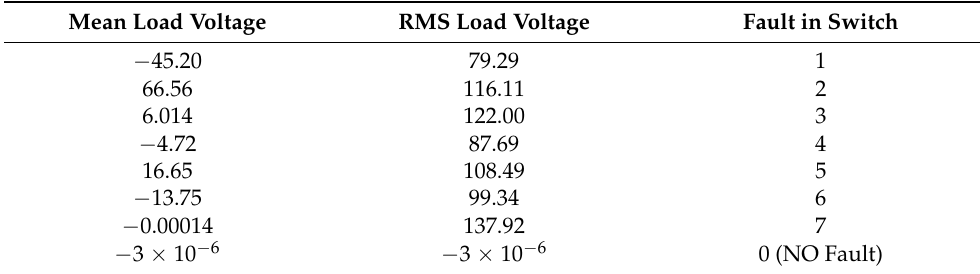
Table 5. Sample dataset